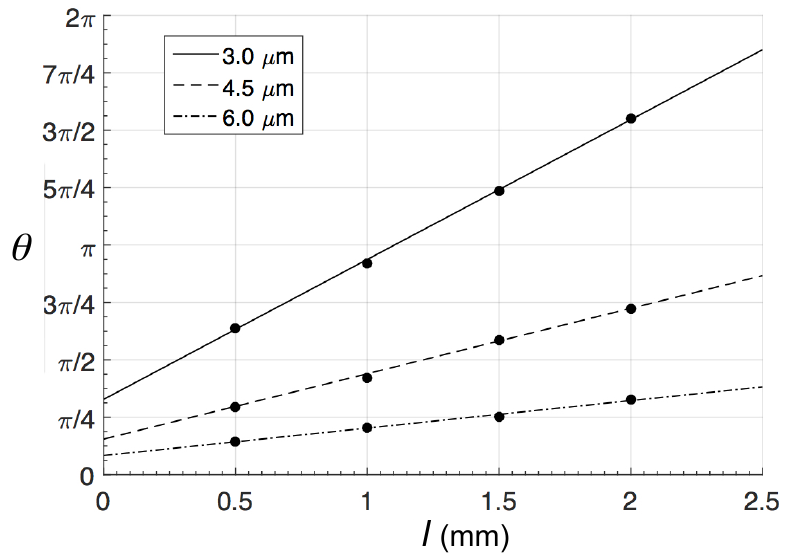
Figure 16. Linear fits of the coupling θ ( l ) for the three separations s between channel guides of twelve directional couplers.